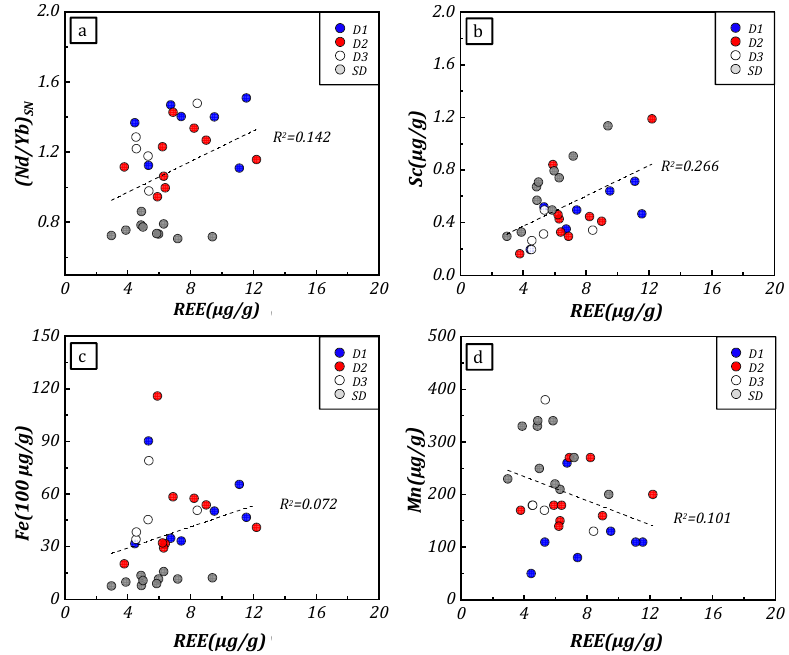
Figure 9. Cross-plot of ( a ) (Nd/Yb) SN ratio, ( b ) Sc concentration, ( c ) Fe concentration, and ( d ) Mn concentration with Σ REE of the investigated Xixiangchi dolomites. Note the Fe, Mn, and REE concentration of some of D1, D2, and SD samples have been previously reported by Liang et al. [45]. See Table S4 for details.